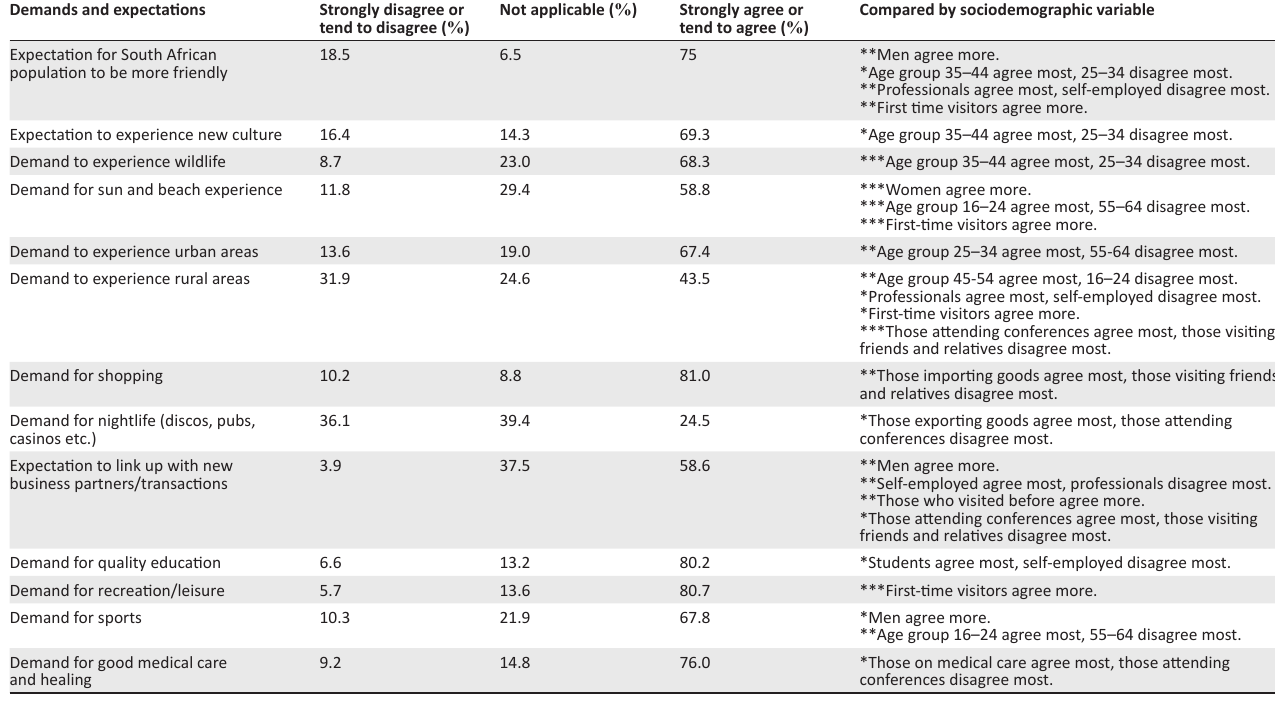
TABLE 4: Sociodemographic characteristics of the respondents versus visit demands and expectations ( n = 313). Demands and expectations Strongly disagree or Not applicable ( % ) Strongly agree or Compared by sociodemographic variable tend to disagree ( % ) tend to agree ( % ) Expectation for South African population to be more friendly